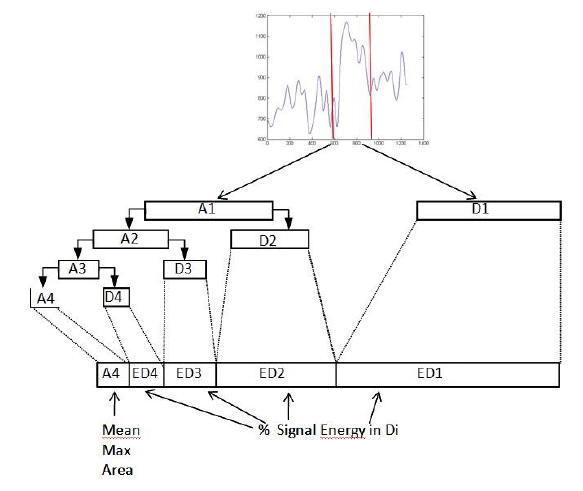
Fig. 4. Construction of the feature vector for one candidate peak. Mean, amplitude and area are calculated from the A4 com- ponent, the relative energy from the detail coefficients.